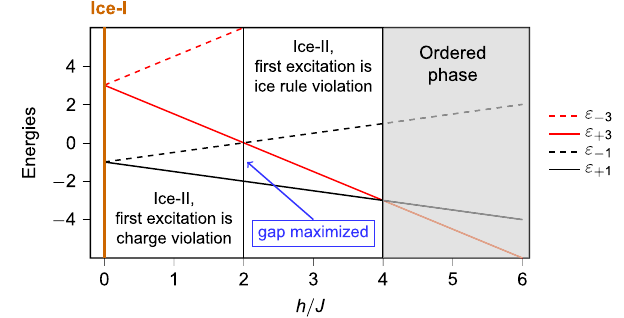
Fig.2|Icevertexenergies(normalizedto J ). IntheIce-Iphase( h =0),theice-rule vertex states ε +1 and ε − 1 are degenerate (the subscripts denote the staggered charge). Detuning h leads to an energetic preference towards the (staggered) +1- charged con fi gurations. Within the ice region 0 ≤ h / J ≤ 4, the energy gap is max- imized at h / J =2, where charge-imbalance excitations degenerate with ice-rule